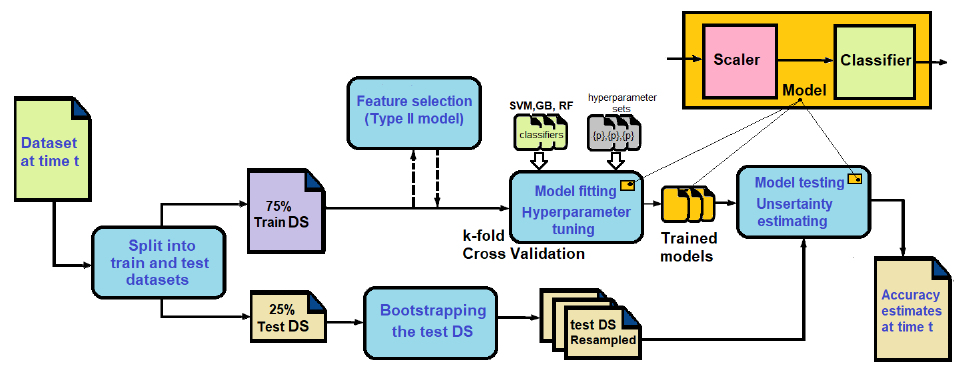
Figure 13. Machine learning